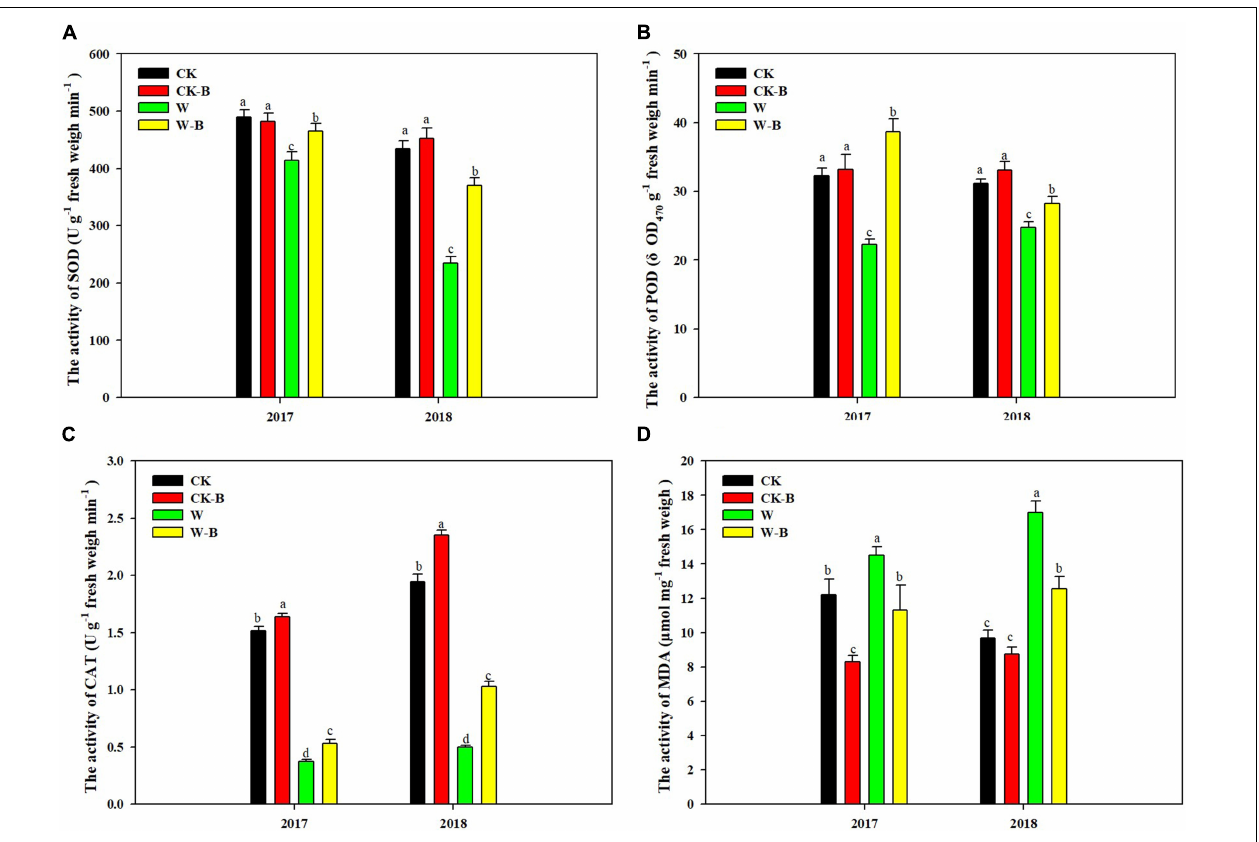
FIGURE 1 | The effects of 6-BA on the activities of antioxidant enzymes and the content of MDA in the filaments of apical florets. (A) SOD; (B) POD; (C) CAT; (D) MDA. CK, control, no waterlogging stress; CK-B, spraying 6-BA on non-waterlogged plants; W, waterlogging; W-B, spraying 6-BA after waterlogging. Different letters on bars indicate the significant differences among treatments at P < 0.05 using the LSD